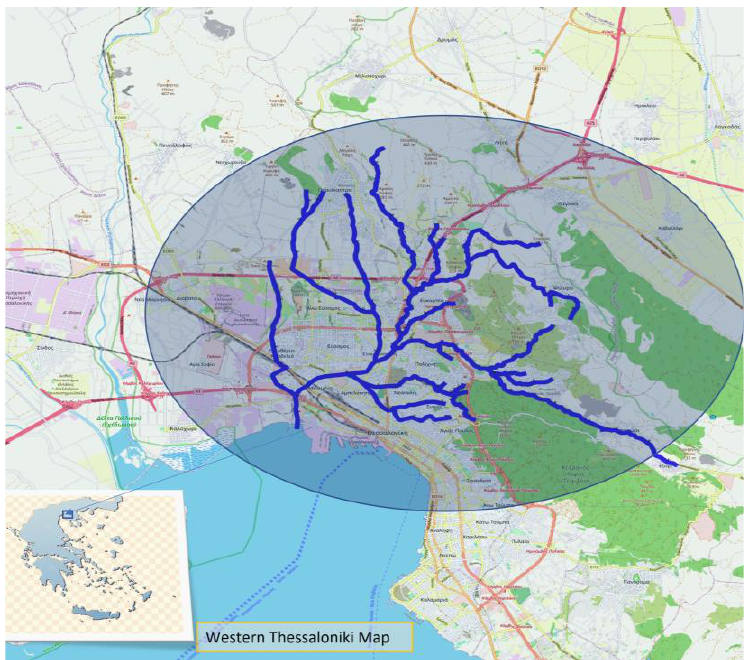
Figure 1. Western Thessaloniki map showing the Dendropotamos stream network .